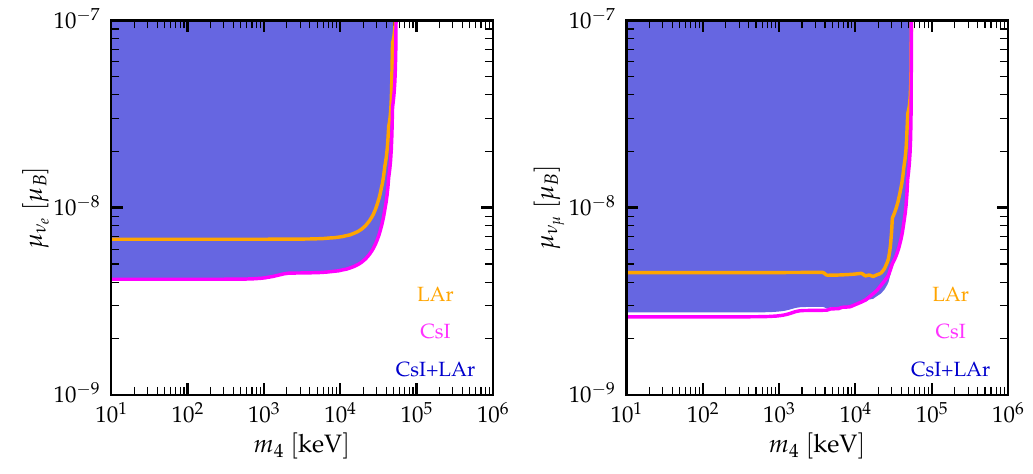
Figure 15 . 90% C.L. (2 d.o.f.) exclusion regions for the neutrino magnetic moments concerning active-to-sterile transitions, from the analysis of CsI (magenta), LAr (orange) and CsI + LAr (blue) data. The analysis of CsI data includes CE ν NS + ES